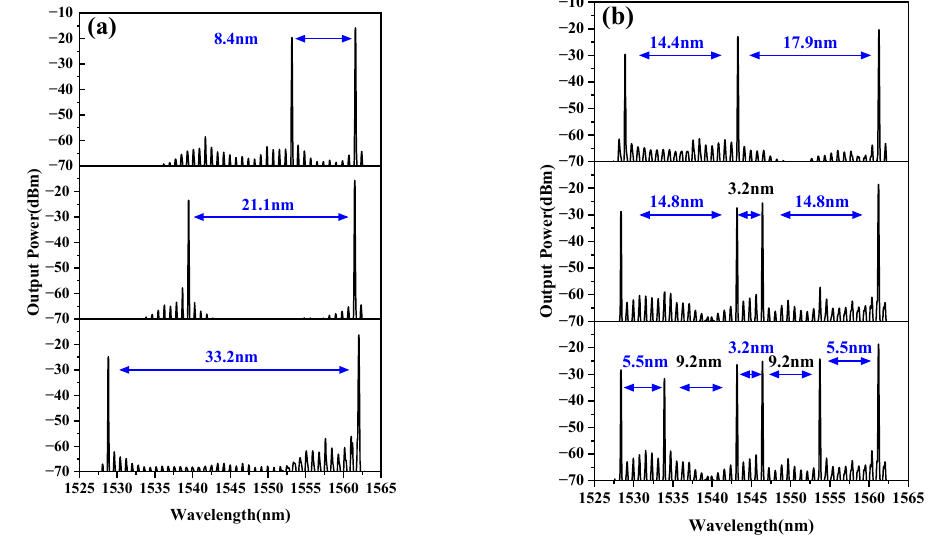
Figure 8. Output spectra of tunable ( a ) dual-; ( b ) triple-, quad-, and sextuple-wavelength with different intervals.